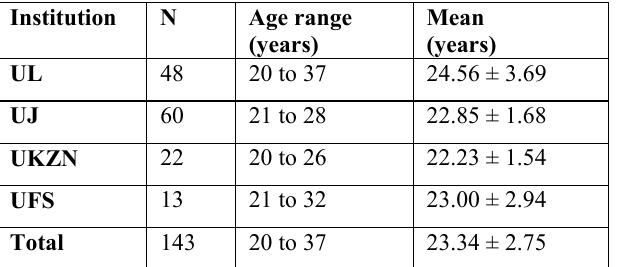
Table 2 : Showing the institutions, number of participants (N), and ages of the participants).